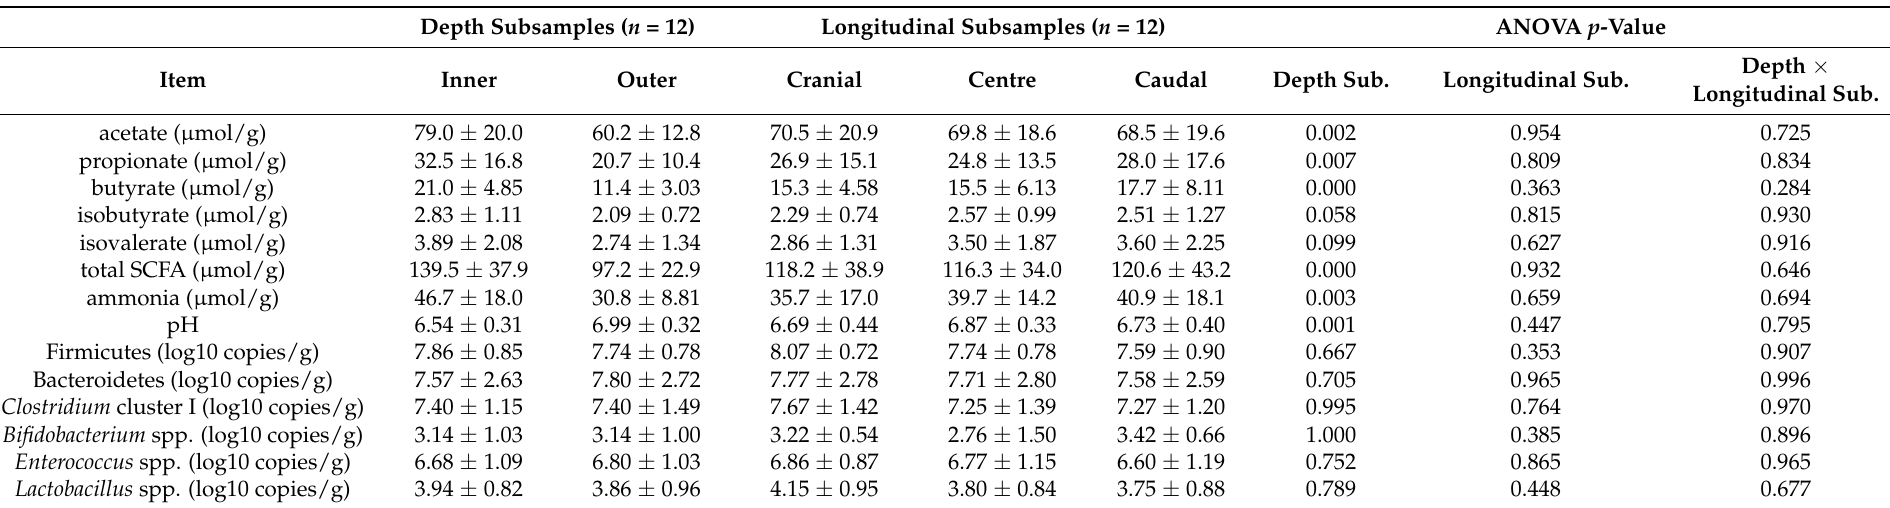
Table 1. Mean ± standard deviation (SD) values for short-chain fatty acids, ammonia, pH and microbial populations determined in depth and longitudinal stool subsamples collected from five different